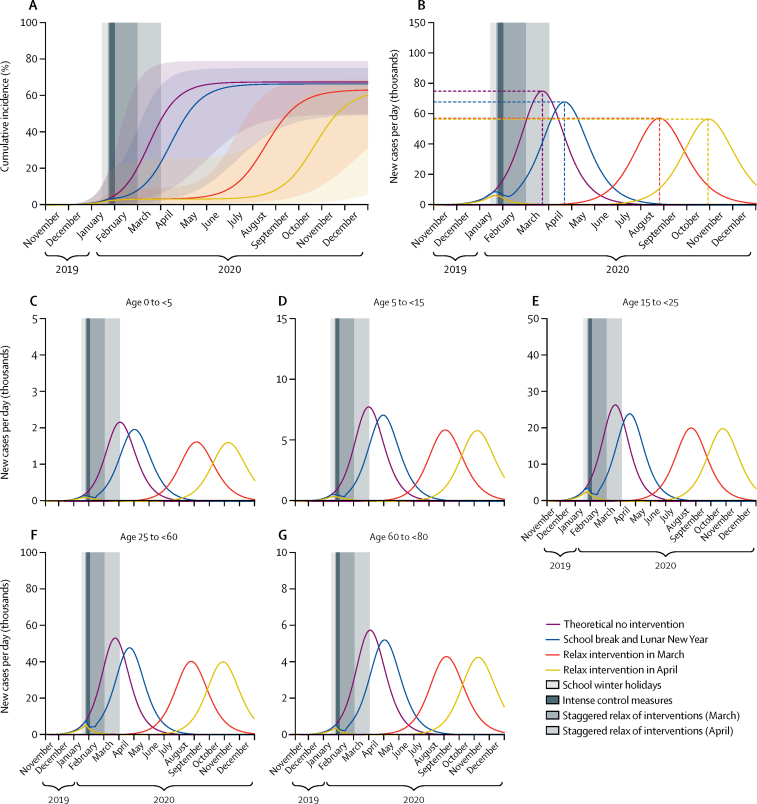
Effects of different physical distancing measures on cumulative incidence (A) and new cases per day (B), and age-specific incidence per day (C to G) from late 2019 to end-2020Results depicted here assume an infectious period of 7 days. Median cumulative incidence, incident cases per day, and age-specific incidence per day are represented as solid lines. Shaded areas around the coloured lines in panel A represent the IQR.